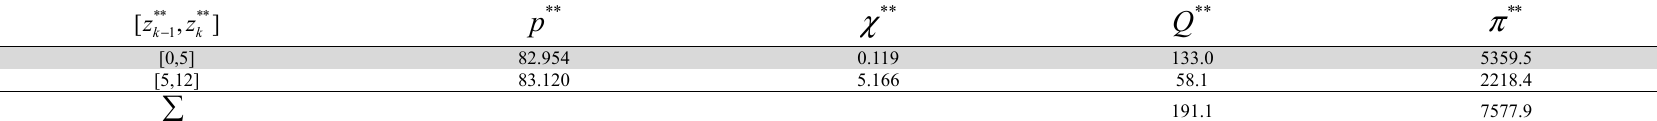
Joint decisions and profits of the manufacturing-only EM setting (policy 2) under representative scenarios